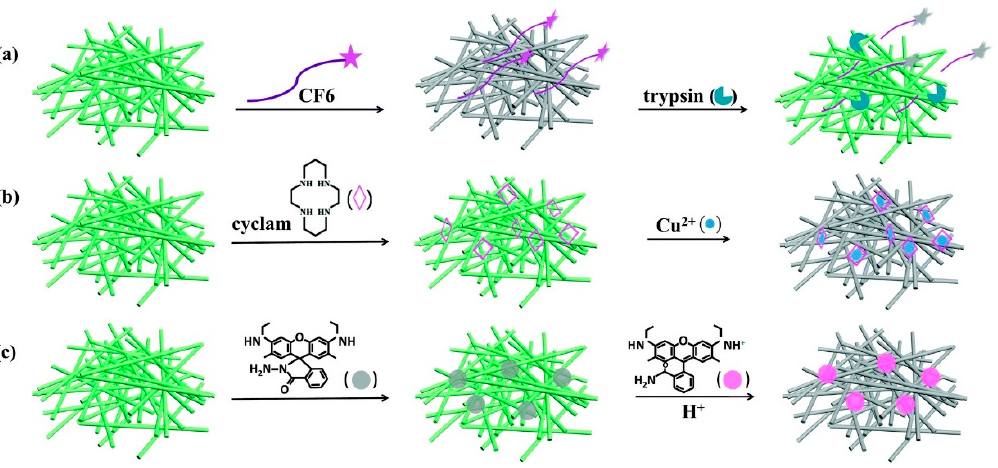
Figure 19. Schematic illustration of ( a ) trypsin, ( b ) Cu 2+ and ( c ) pH fluorescence detection, based on the CPBQD/PMMA FM (reproduced with the permission from reference [190]).